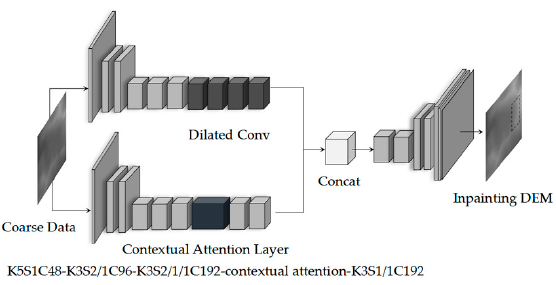
Figure 2. Unified inpainting network.